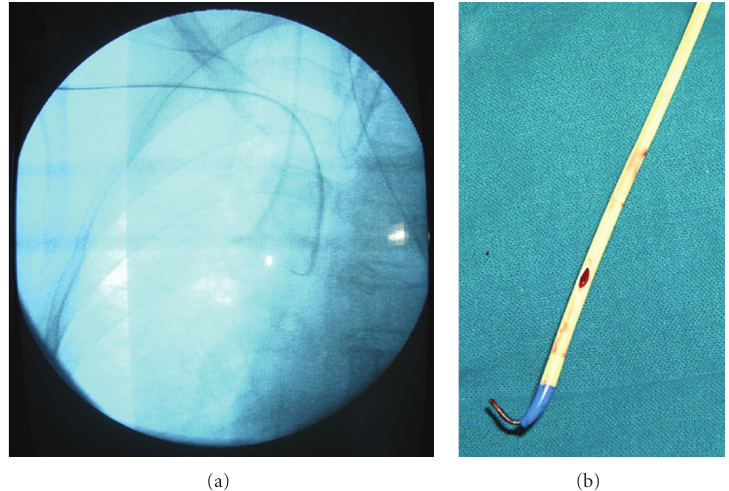
Figure 2: (a) Fluoroscopic image showing the right subclavian CVC with the guidewire and the ipsilateral internal jugular CVC and (b) the undamaged CVC upon removal. CVC: central venous catheter.